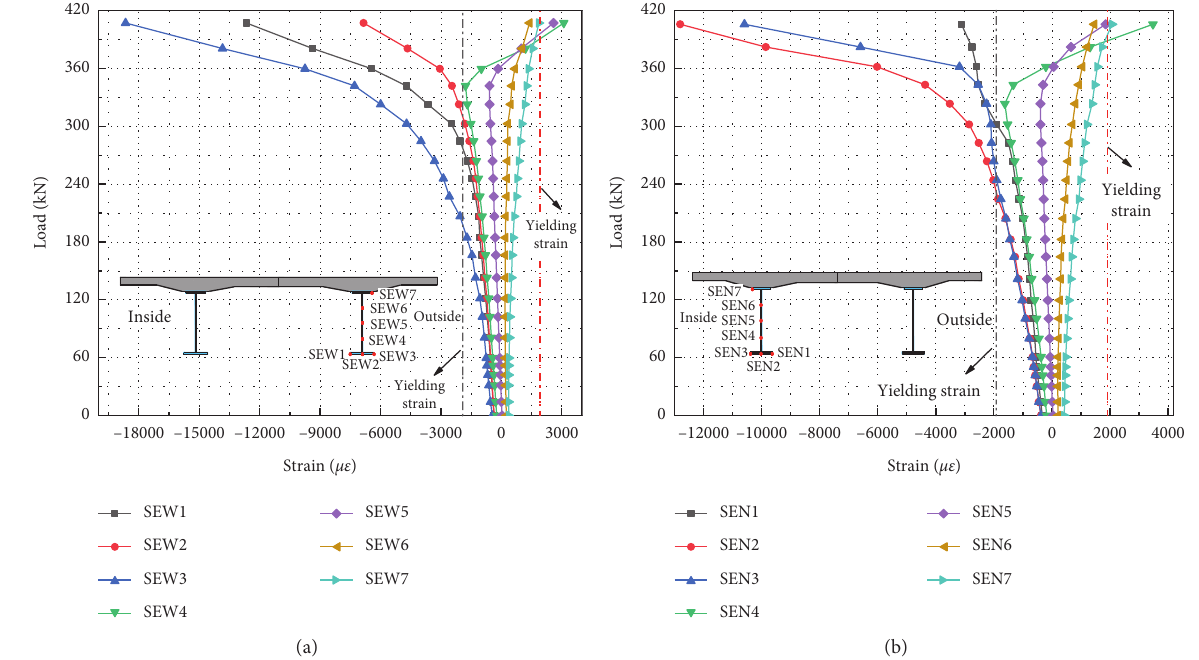
Figure 8: Load-strain curves of steel main girders at the intermediate support section (a) on the external steel main girder and (b) on the internal steel main girder.